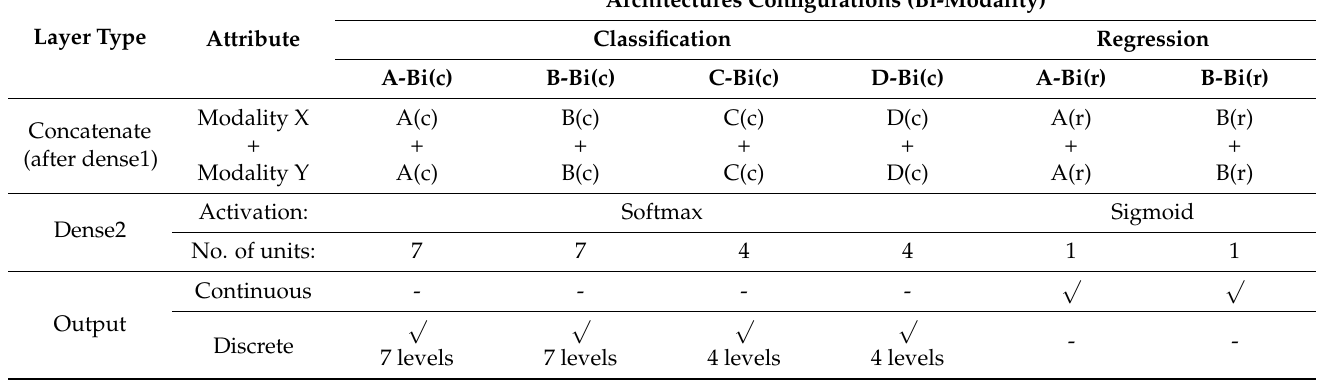
Table 4. A summary of the LSTM/LSTM-SW architectures’ configurations using data